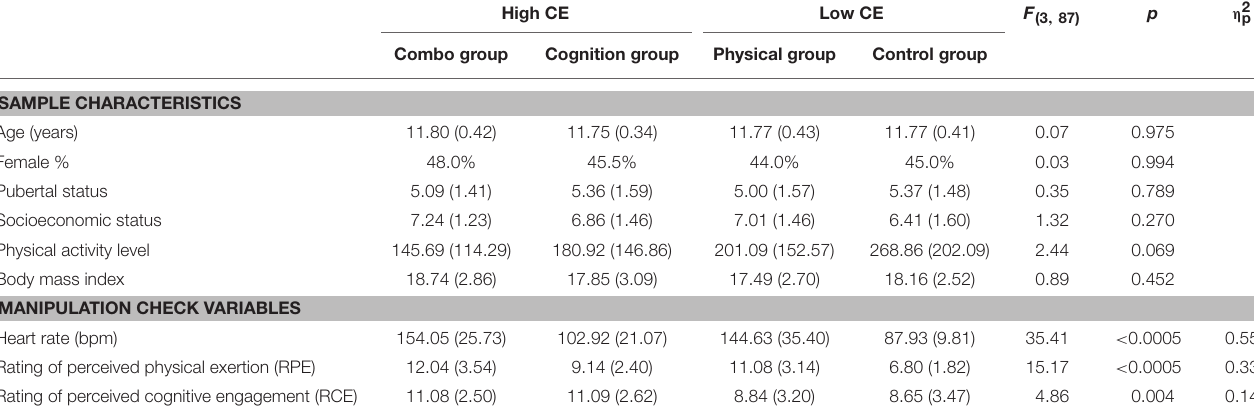
TABLE 1 | Means (standard deviations in parenthesis) and test statistics for the background and manipulation check variables of the four